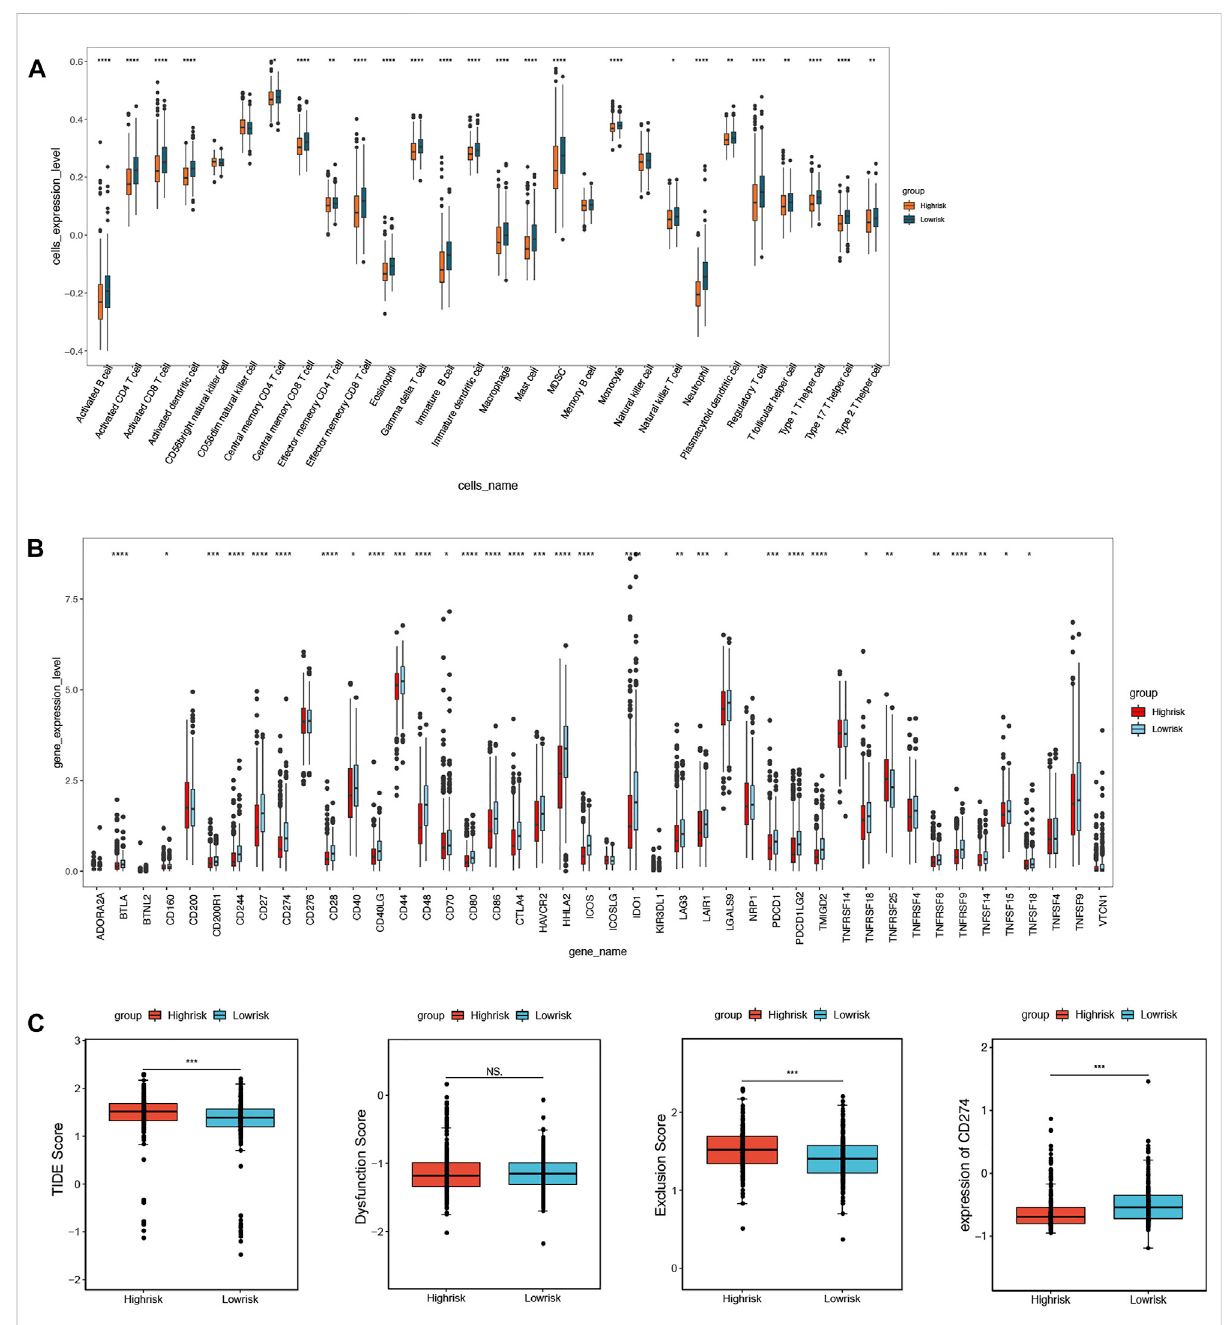
FIGURE 8 Immune microenvironment analysis between high- and low-risk groups. (A) 24 immune cells signi fi cantly different based on immune cell in fi ltration analysis. (B) 32 immune checkpoints signi fi cantly different based on immune checkpoints analysis. (C) TIDE scores, T-cell exclusion scores, and PD-L1 scores signi fi cantly different based on TIDE